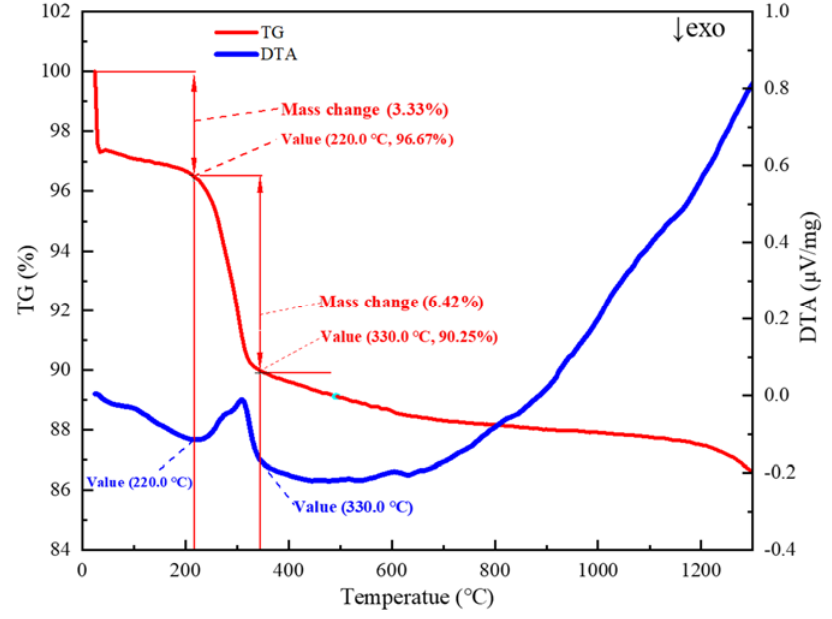
Figure 5. TG ‐ DTA curve of limonite roasting process. Figure 5. TG-DTA curve of limonite roasting